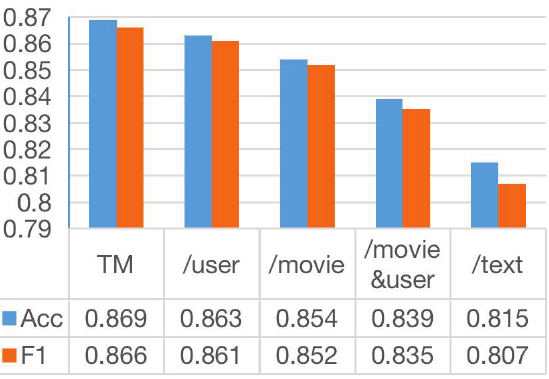
Figure 7. Ablation experiments of Spam Reviews Detection (/ means without).